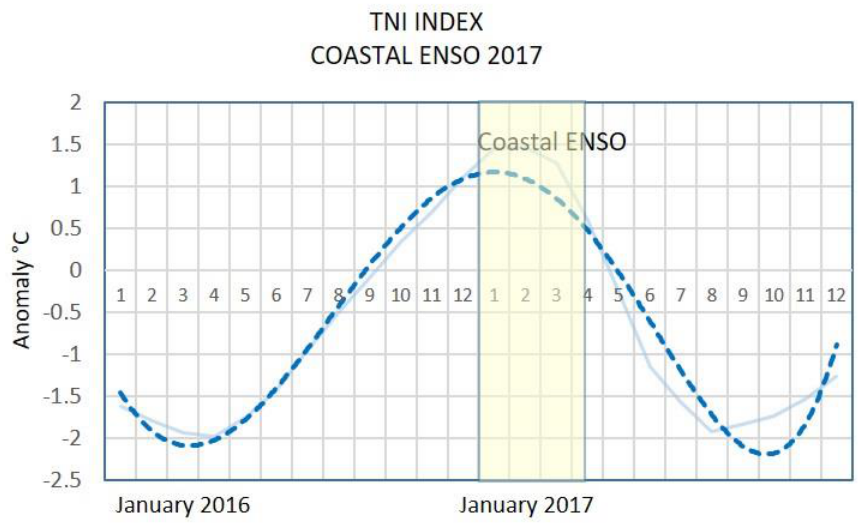
Figure 4. Time series of the Trans ENSO Index (TNI), for the years 2016 and 2017. In 2017, a positive phase was observed, indicating the presence of coastal ENSO.